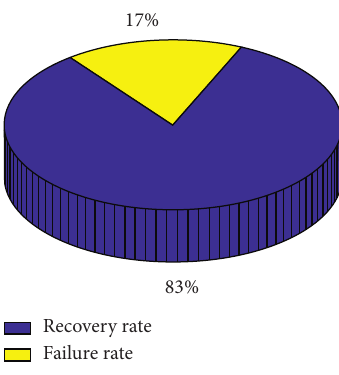
Figure 3: Data on cure rates.